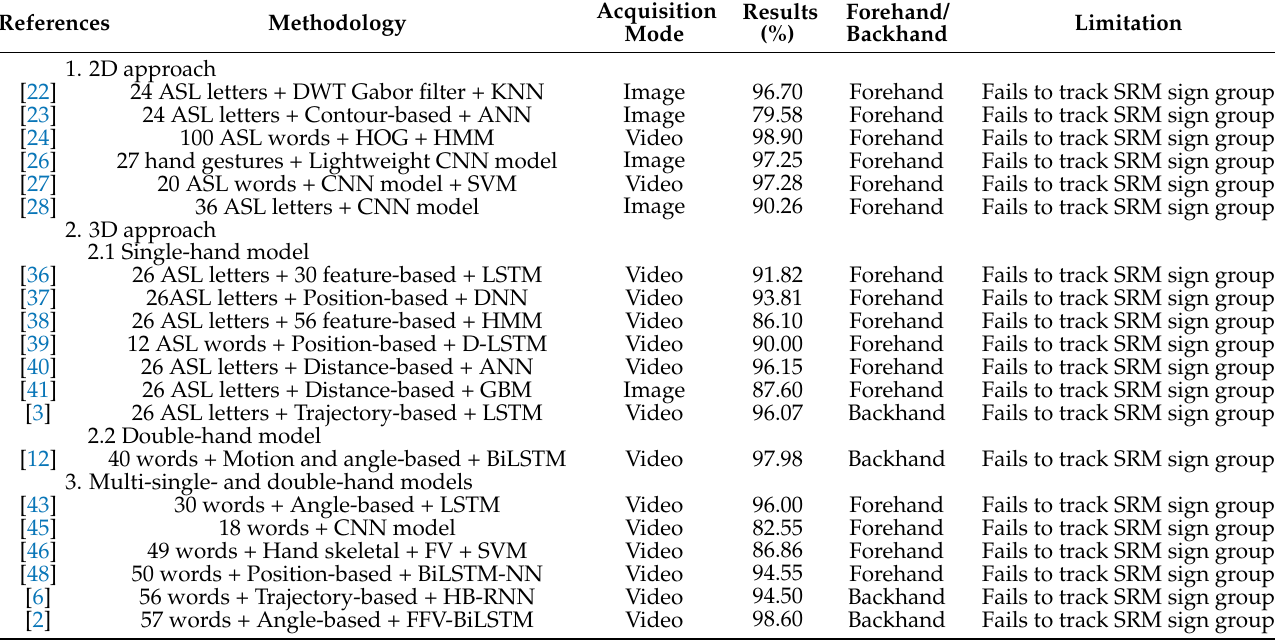
Table 1. Vision-based methods of automatic sign language